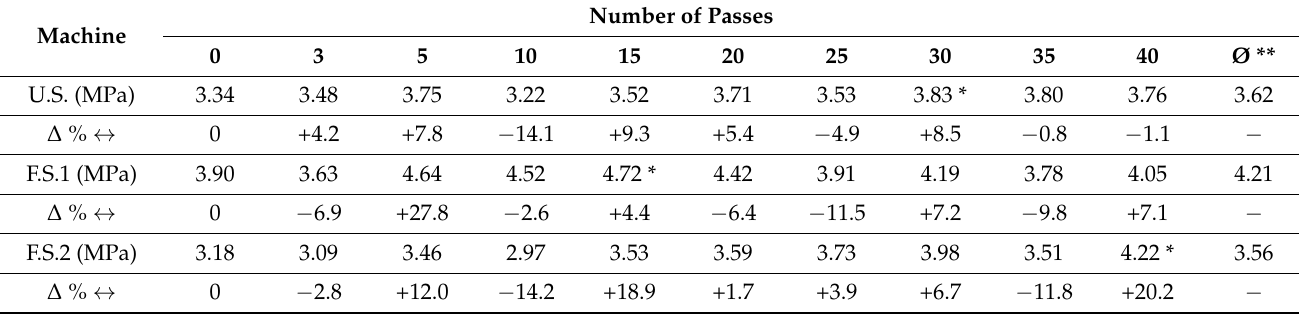
Table 6. Penetration resistance (MPa) and its percentage increase/decrease relative to the number of